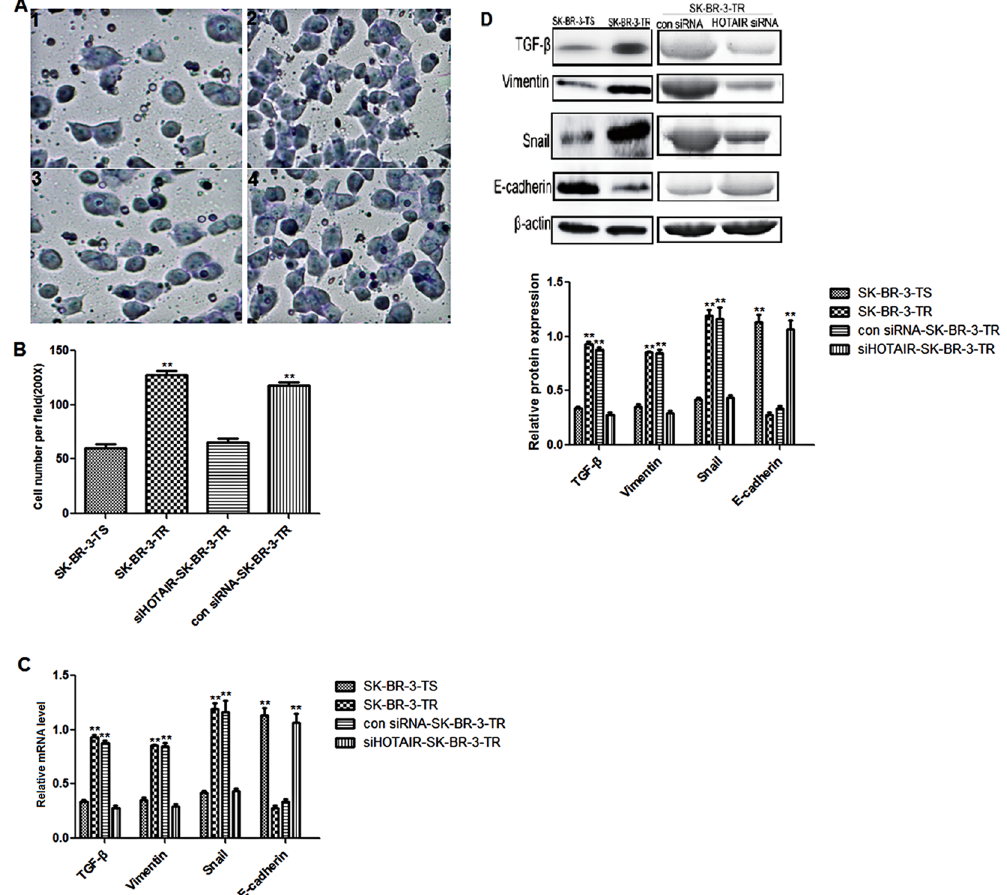
Figure 5. Transwell assay and expression of ETM-related genes in trastuzumab sensitive and resistant cells following HOTAIR knockdown. ( A ) 1–2, microphotos of trastuzumab sensitive and resistant cells in Transwell assay, 3–4, microphotos of trastuzumab resistant cells in Transwell assay after transfected with siHOTAIR and control siRNA ( B ) number of migrated cells; ( C ) mRNA levels of ETM-related genes; ( D ) upper panel, representative Western blots and lower panel: protein levels of ETM-related genes. ** P < 0.01 vs control.